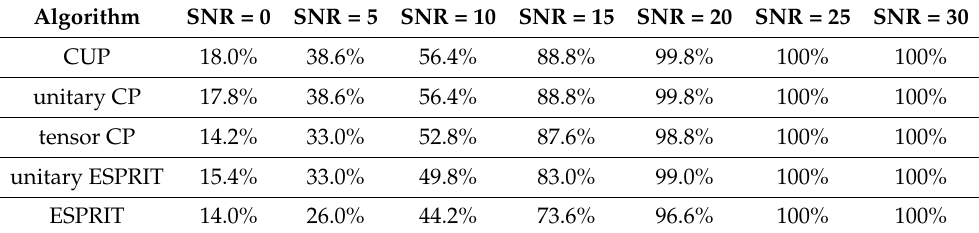
Figure 11. PSD of range estimation versus SNR. Table 8. PSD of range estimation versus